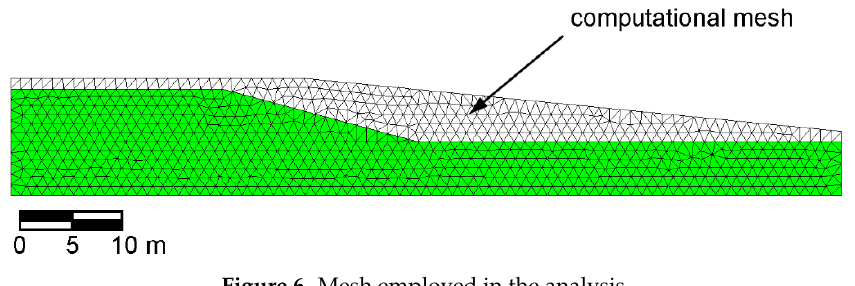
Figure 6. Mesh employed in the analysis.